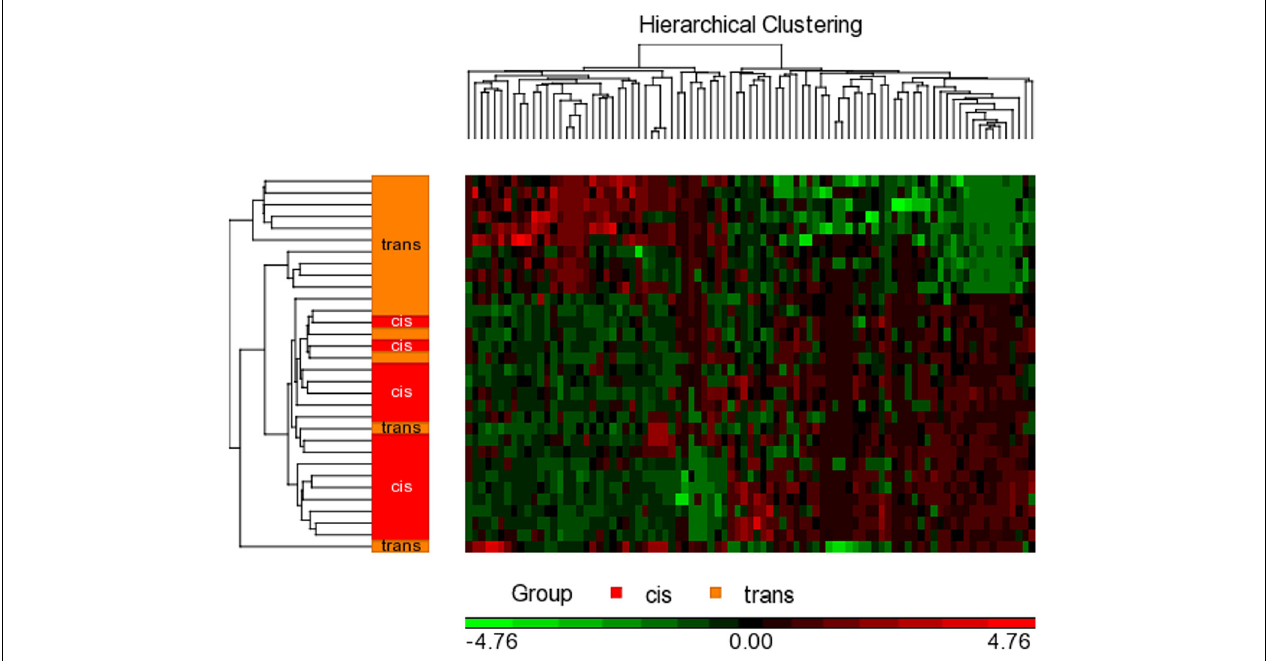
FIGURE 2 | Hierarchical clustering with heat map invoked on the list of significant CpGs FDR p < 0.05 and a fold change ≥ 2.0 in male assigned at birth populations. The experimental groups are rows, while the CpGs from the cisgender vs. transgender spreadsheet are columns. CpGs with higher methylation are colored red, CpGs with lower methylation are colored green. Samples of transgender people are colored orange and samples of cisgender people are colored red in the dendrogram on the left-hand side of the heat